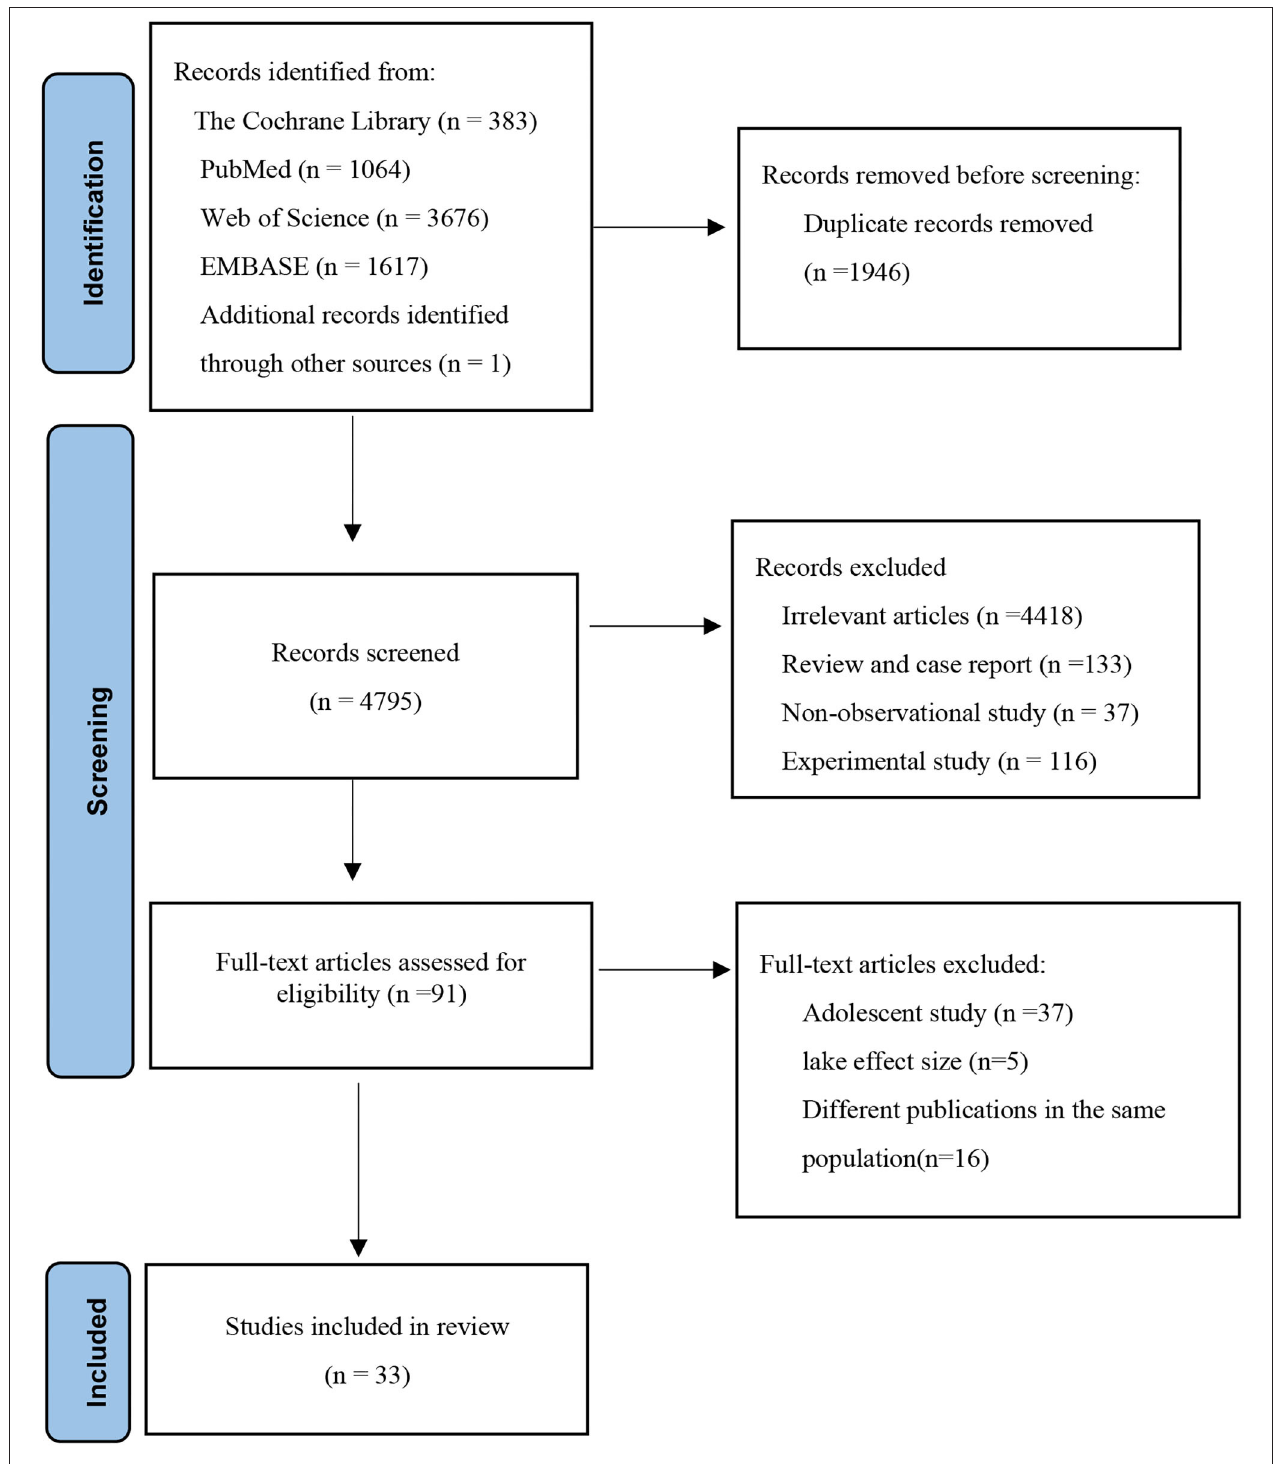
FIGURE 1 | A flow diagram outlining the systematic search and article selection process.